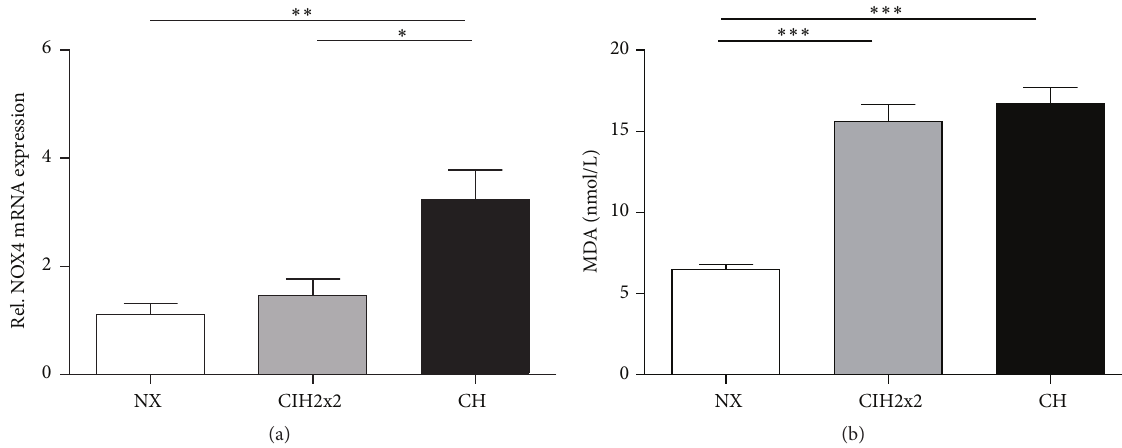
Figure 5: Comparison of (a) mRNA expression levels of NOX4 determined by qRT-PCR and (b) MDA concentrations (nmol/L) determined by spectrophotometry of lung tissue from rats exposed to normoxia (NX), chronic intermittent hypoxia (CIH2x2), or chronic sustained hypoxia (CH). Values are expressed as means and SE. ∗ 𝑝 < 0.05 ; ∗∗ 𝑝 < 0.01 ; ∗∗∗ 𝑝 < 0.001 ; 𝑛 = 8 in each